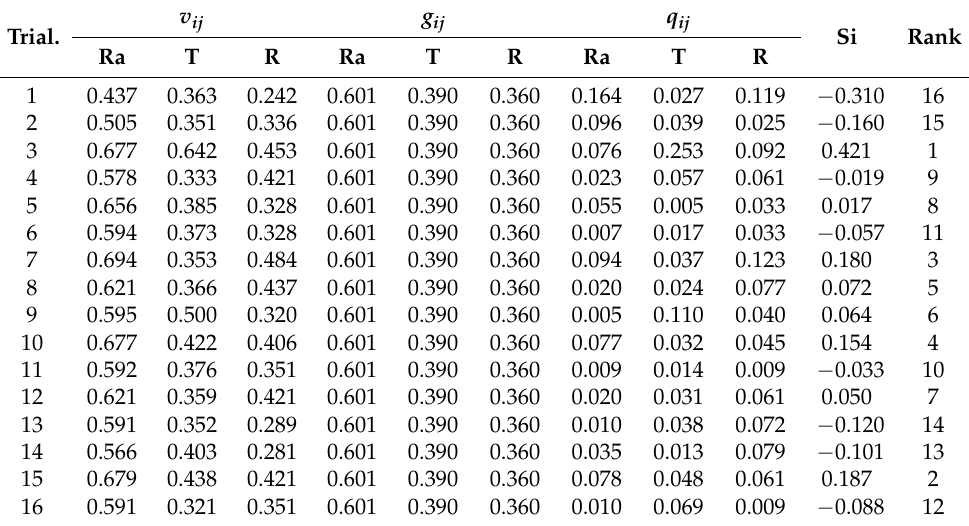
Table 4. Calculated results when using MABAC and entropy methods. Trial.